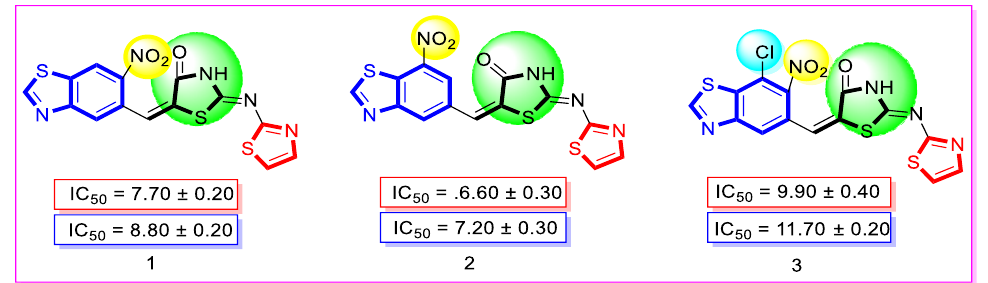
Figure 3. SAR study of analogues 1, 2 , and 3. Analogues 4 and 5 bore fluoro groups at the meta- and ortho -position, respectively, and exhibited the highest potential against α -amylase and α -glucosidase in comparison to acarbose. The effective nature of analogues 4 and 5 against α -amylase and α -glucosidase activity might be due to the presence of two flouro groups, which interact better with the active site of the enzyme through series of hydrogen bonds. Moreover, the position of the fluoro groups around the phenyl ring has a significant effect to increase the biological activity of analogues. Thus, analogue 5 bore a flouro group at the ortho -position of phenyl ring and showed excellent inhibitory potential than the meta- substituted analogue 4, which was considered as the top-ranked analogue, or the series was found with a few folds better potential than acarbose as shown in Figure 4.